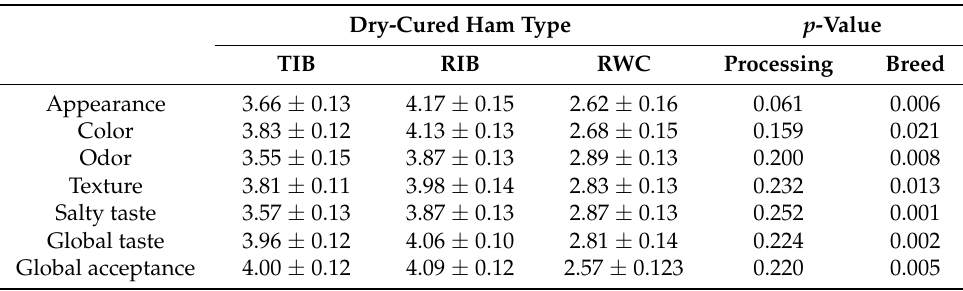
Table 6. Effect of Iberian dry-cured ham type (processing) and effect of breed on consumer accept- ability by a consumer panel. Results are expressed as mean values ± SEM